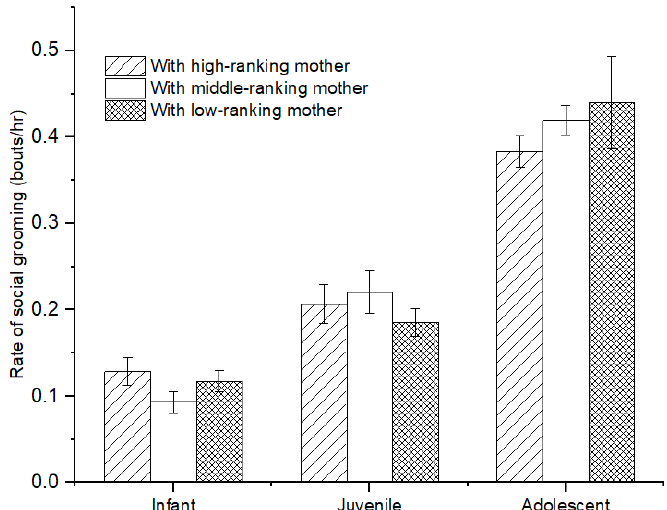
Figure 4. The rate of social grooming among immature individuals with mothers of different rank categories.